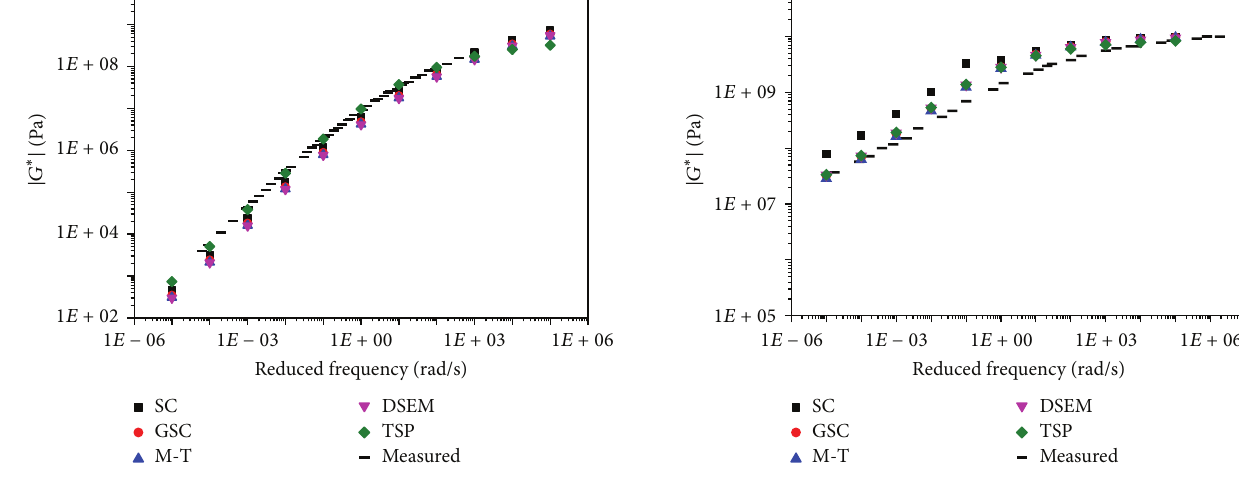
Figure 6: Predicted and measured dynamic shear modulus of